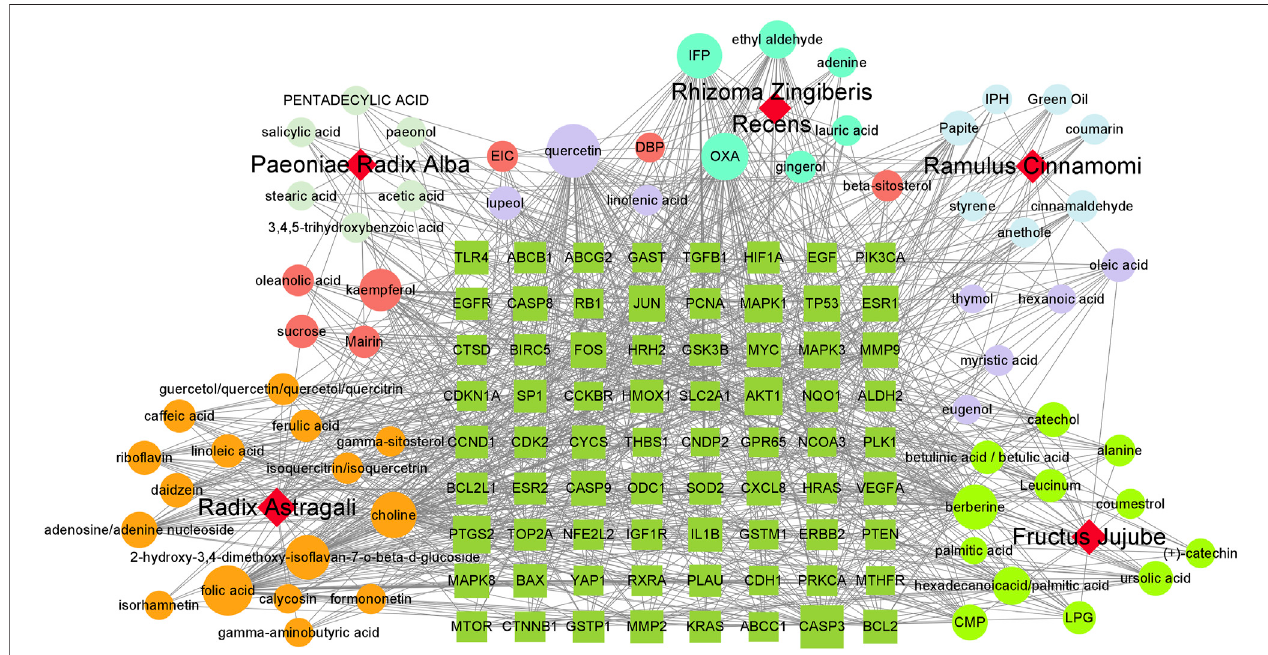
FIGURE2| NetworkoftheHJTherb-component-target.Thedarkgreensquarerepresentsthekeytargetofthecompoundforgastriccancer,circlerepresentsthe compound, and different colors represent the compounds contained in different traditional Chinese medicines; pink and lavender represent compounds found in many types of traditional Chinese medicine; red quadrilateral represents different traditional Chinese